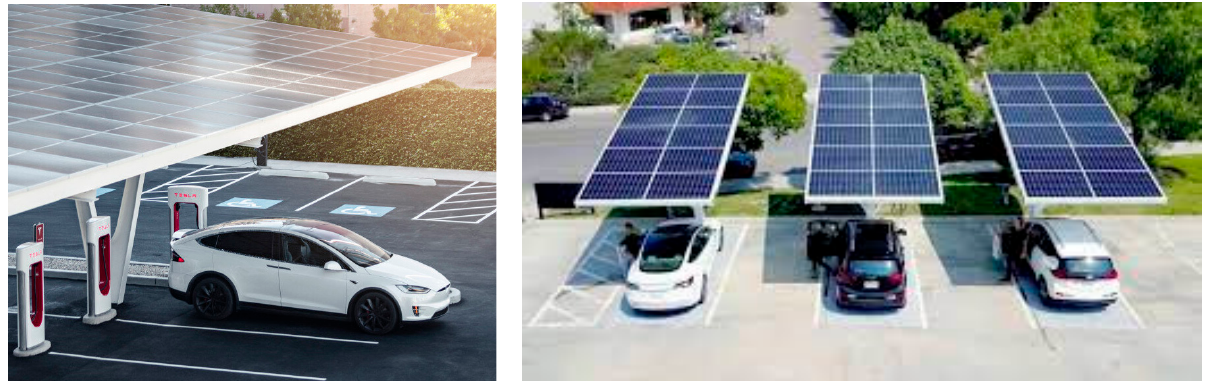
Figure 33. Off-grid solar-powered EV charger [71,72].